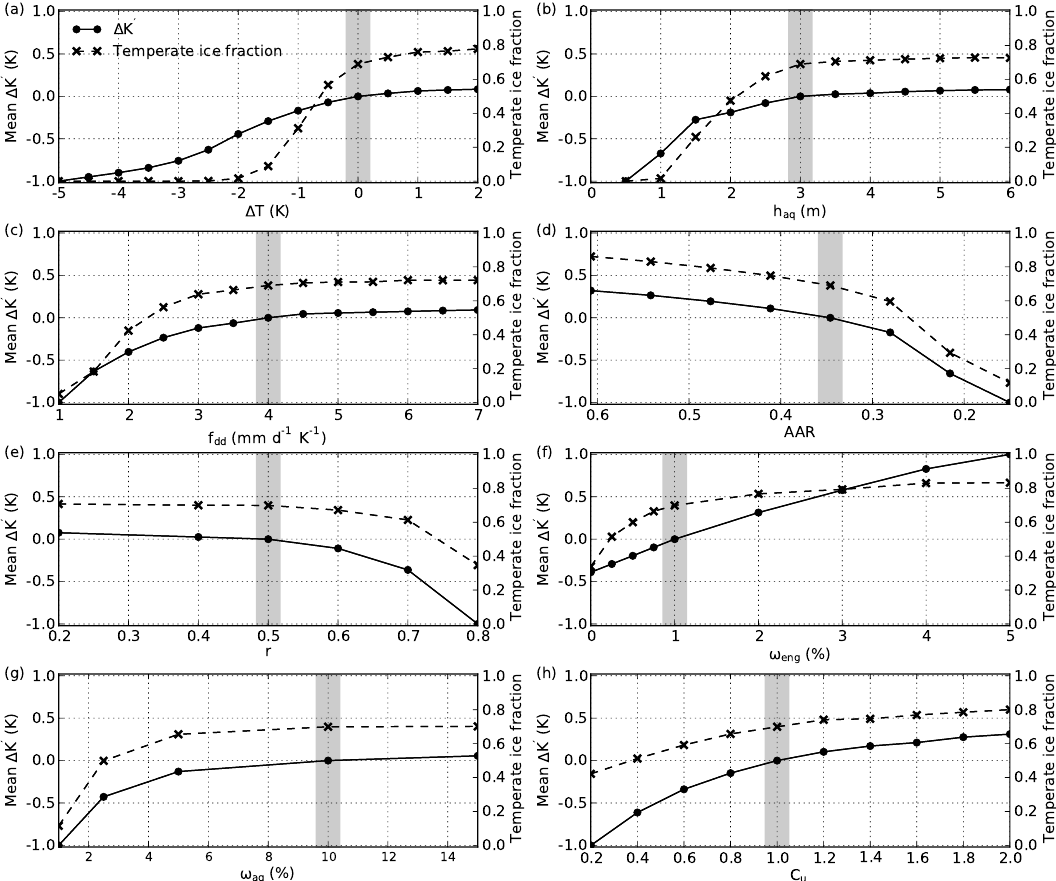
Fig. 4. The results of varying parameters in Table 2, given in terms of mean equivalent temperature difference (solid line, dots) and the fraction of temperate ice (dashed line, crosses). (a) Air temperature offset. (b) Aquifer thickness. (c) Degree-day factor. (d) Equilibrium line altitude, recast as accumulation area ratio assuming a rectangular glacier. (e) Run-off fraction. (f) Maximum englacial water content. (g) Maximum aquifer water content. (h) Advection multiplier. The values used for the reference model are indicated by the vertical grey bars.